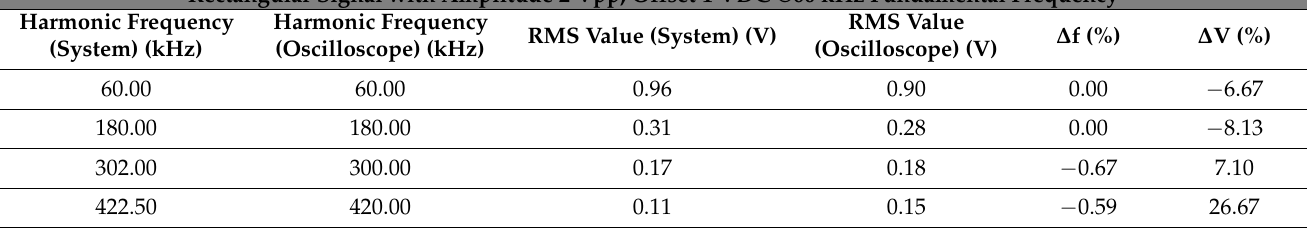
Table 8. Comparisons between the calibrated oscilloscope and the FPGA-based system measurements for rectangular signal with amplitude of 2 Vpp with 1 VDC offset value, for a signal’s fundamental frequency at 60 kHz.